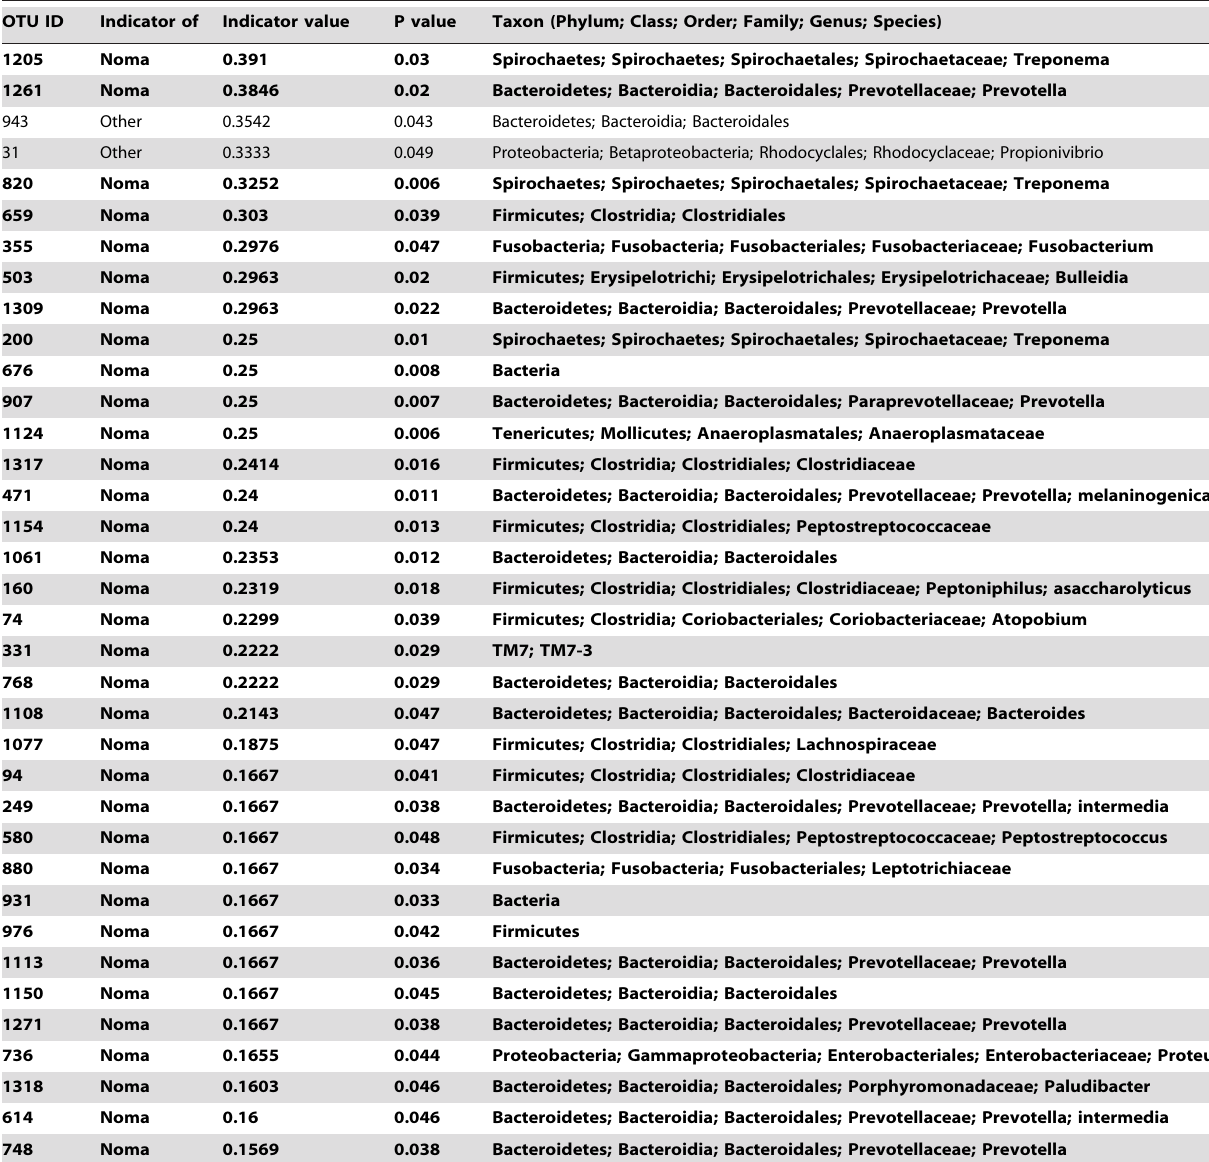
Bacteroidetes; Bacteroidia; Bacteroidales; Prevotellaceae; Prevotella Indicator values were calculated using the abundance distribution of OTUs at the 97% identity cutoff. Boldface highlights the taxa that are indicators for noma. The abundance ranges for taxa with high indicator species values are shown in box plots in Figure 4A. Results with all groups in ‘‘Other’’ being treated separately are shown in Table S6.